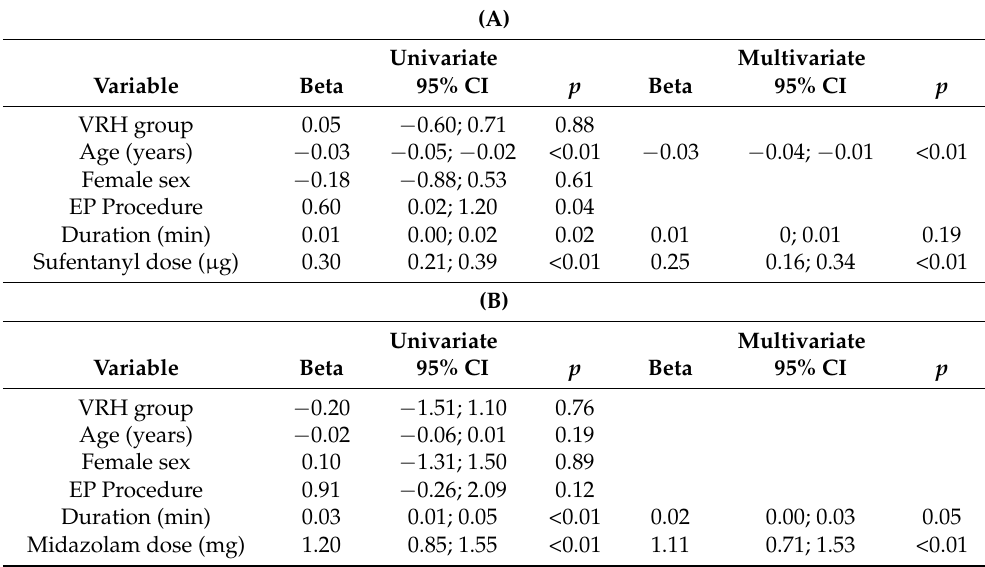
Table 6. Hypnotic and antalgic use. A: Influencing factors of Midazolam use. B: Influencing factors of sufentanyl use. VRH: virtual reality hypnosis; EP procedure: electrophysiological procedure; CI: confidence